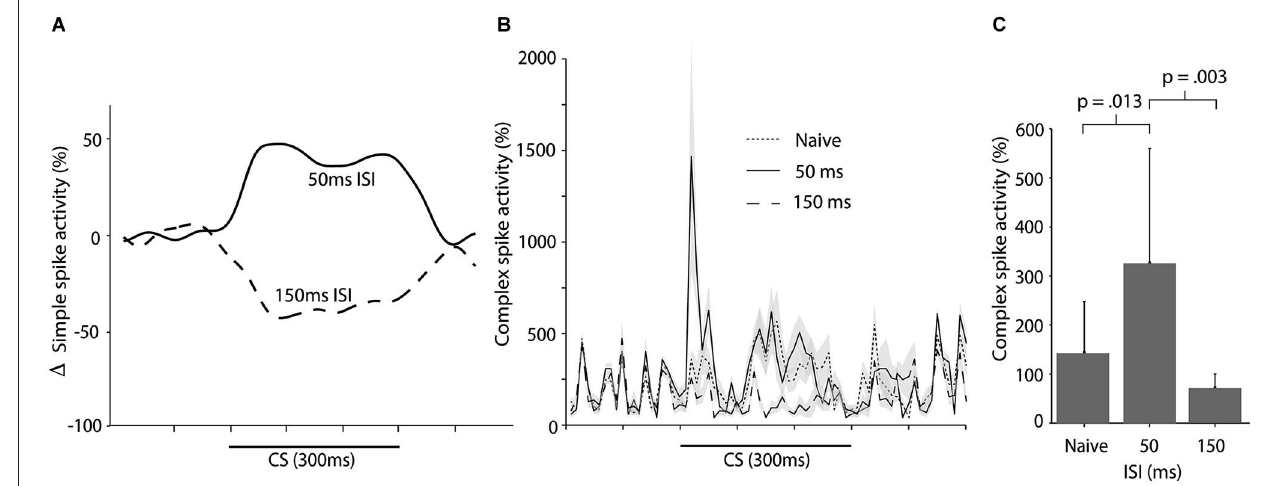
( n = 10) ISI. For each session the data was binned in 10 ms bins and then averaged over all trials. Activity is expressed as a percentage of the background activity, defined as the activity in the second preceding the CS onset. (C) Histogram illustrating the average complex spike frequency and standard deviation (error bars) in naïve cells and in cells trained with either a 50 ms or 150 ms ISI, in the first 100 ms of the CS.